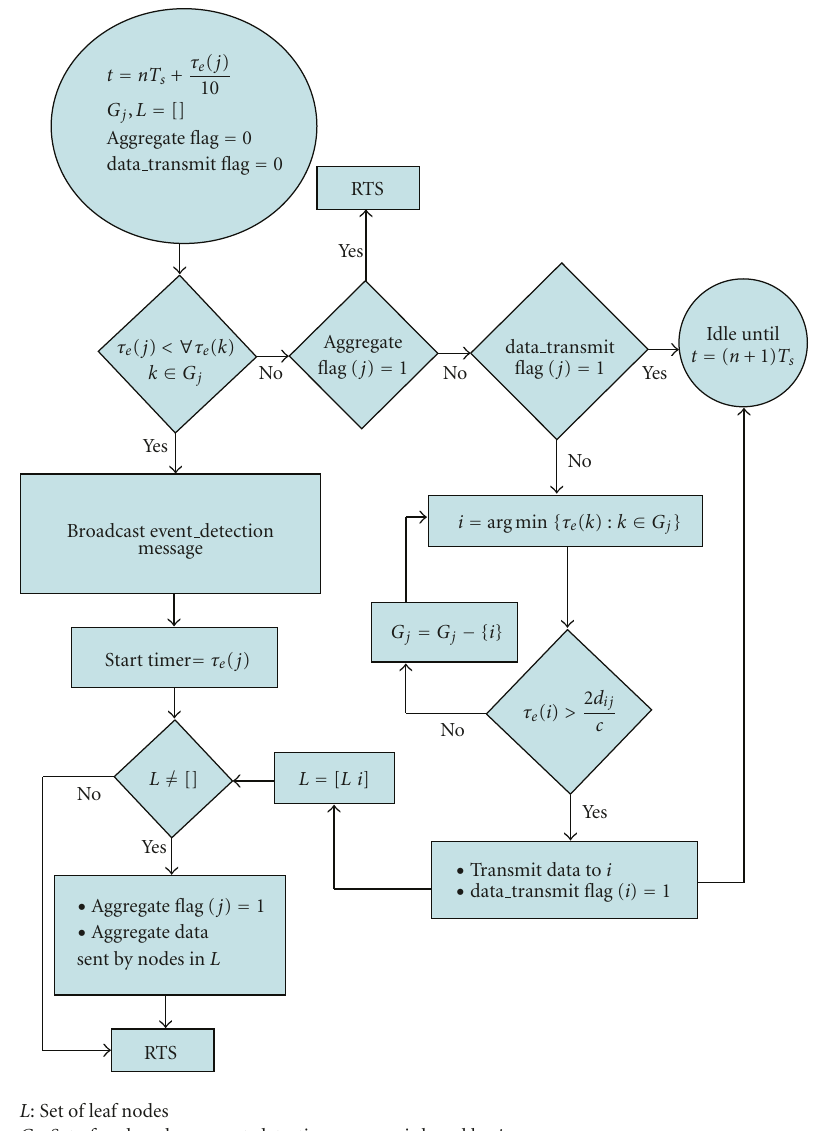
Figure 6: Flowchart of DVD in event